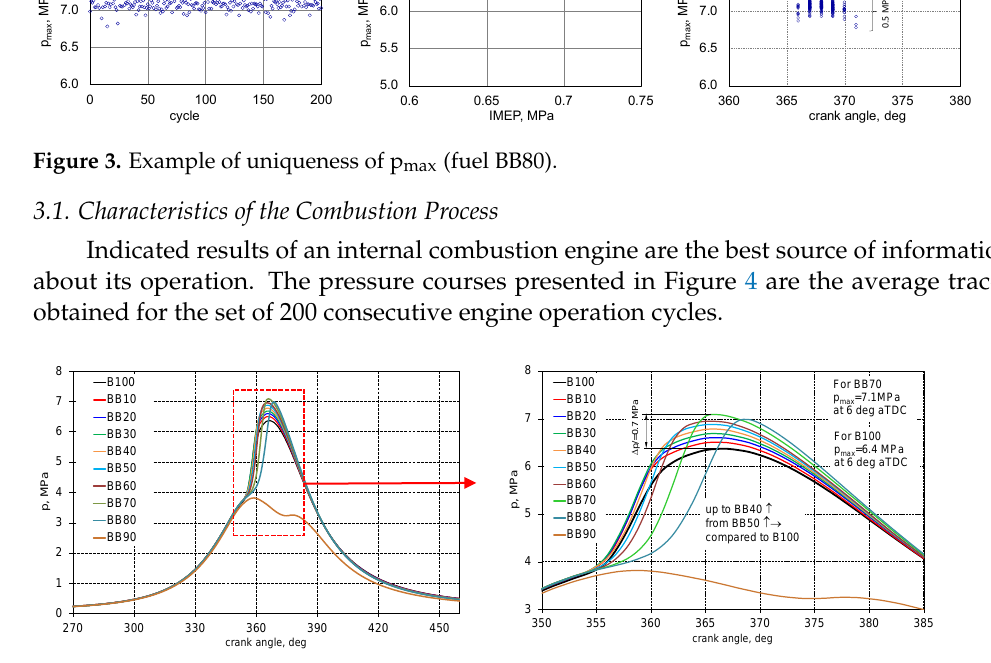
Figure 4. Mean pressure trace for analyzed cases.